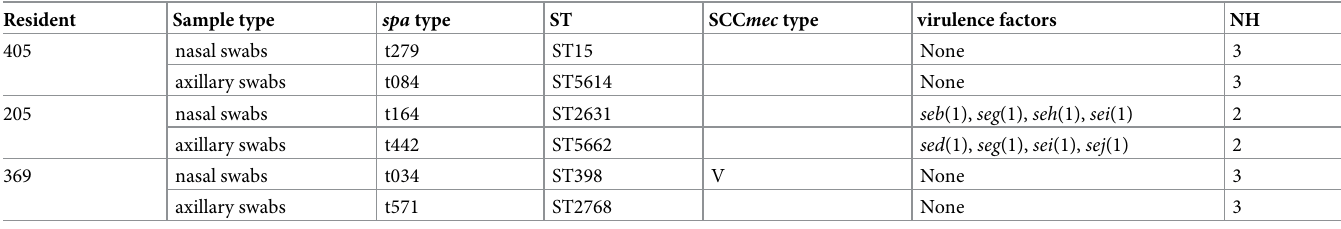
Table 6. Molecular characteristics of six Staphylococcus aureus strains collected from three residents.